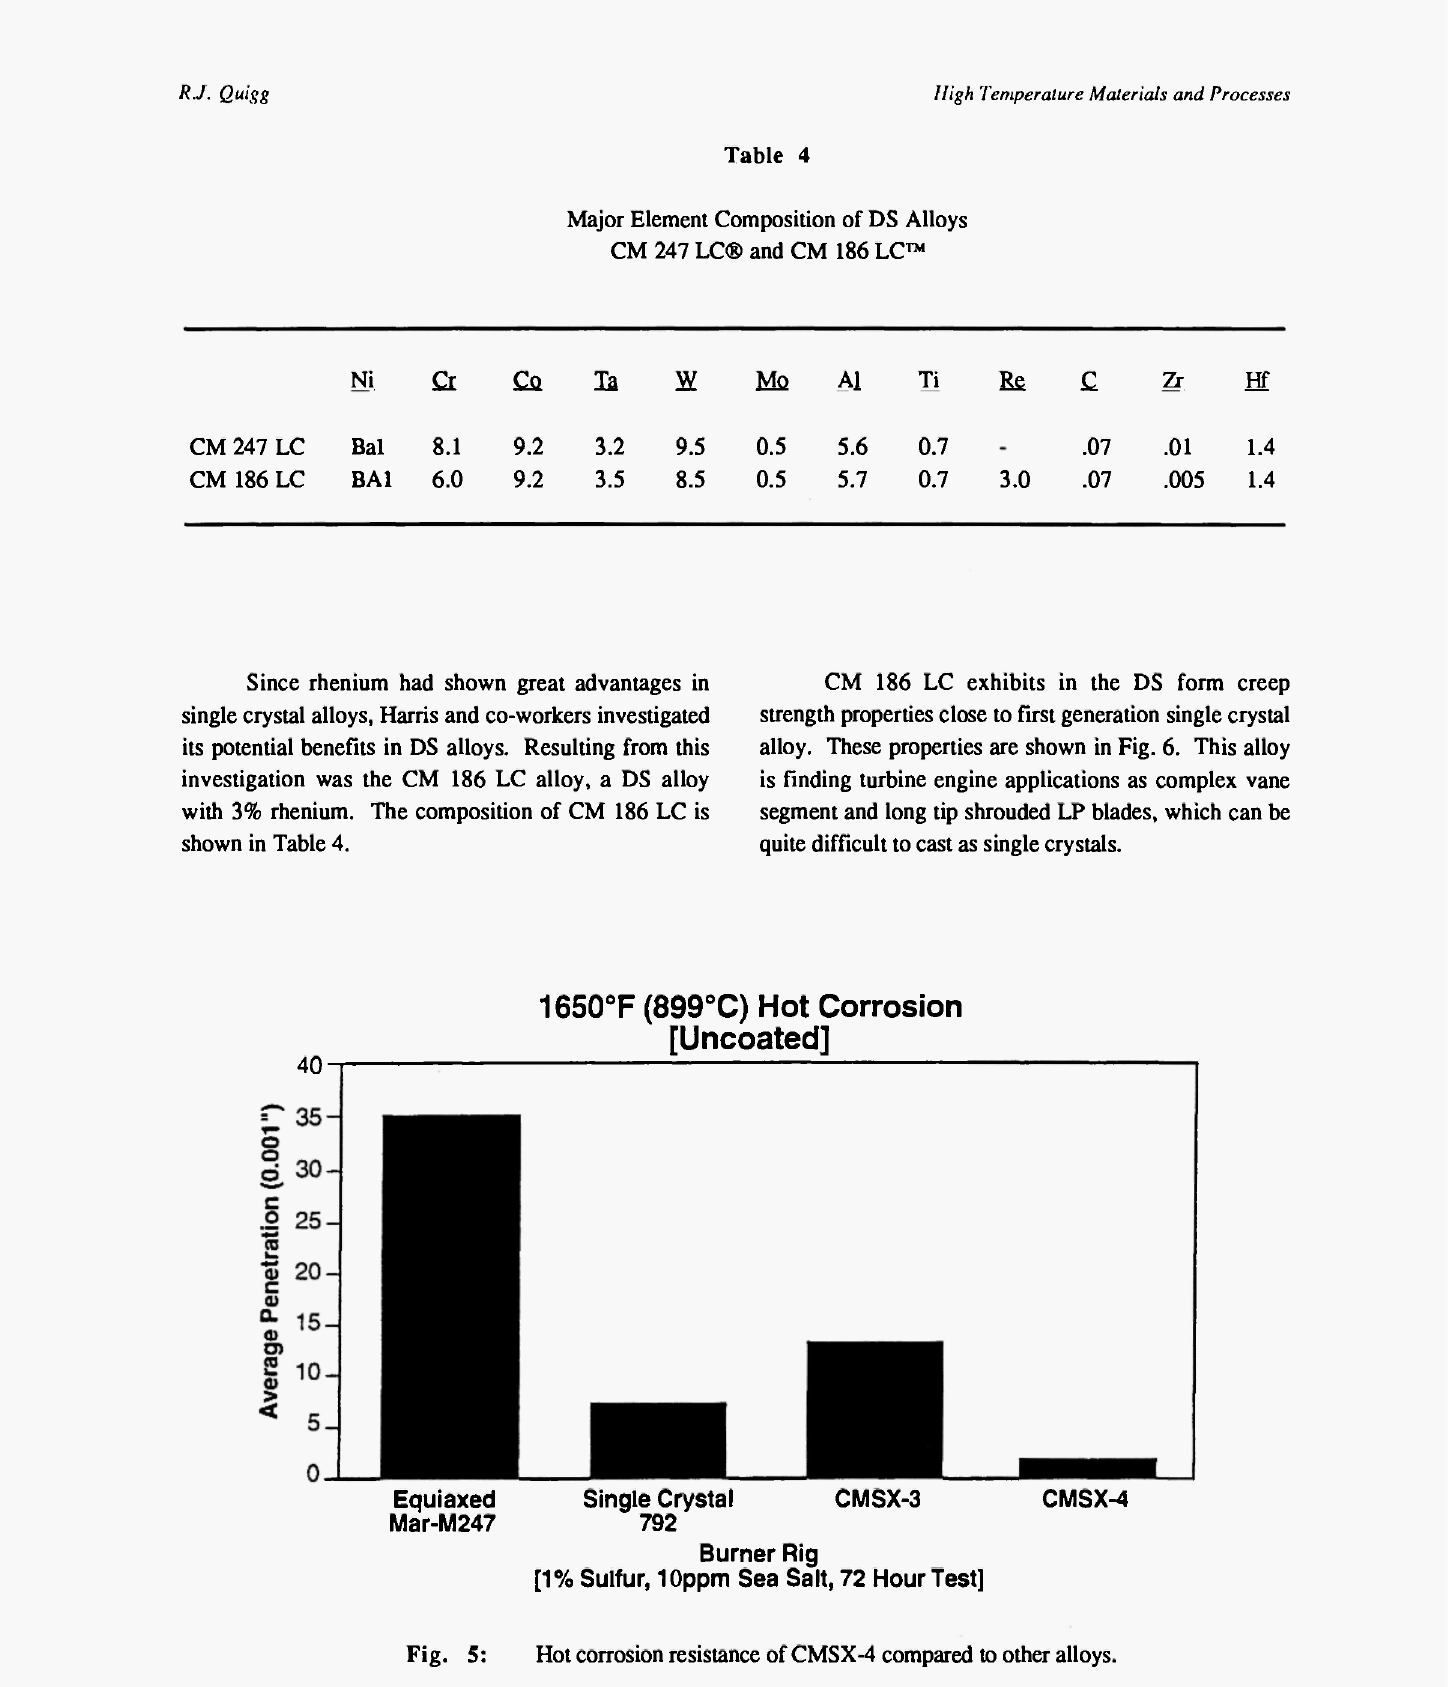
Fig. 5: Hot corrosion resistance of CMSX-4 compared to other